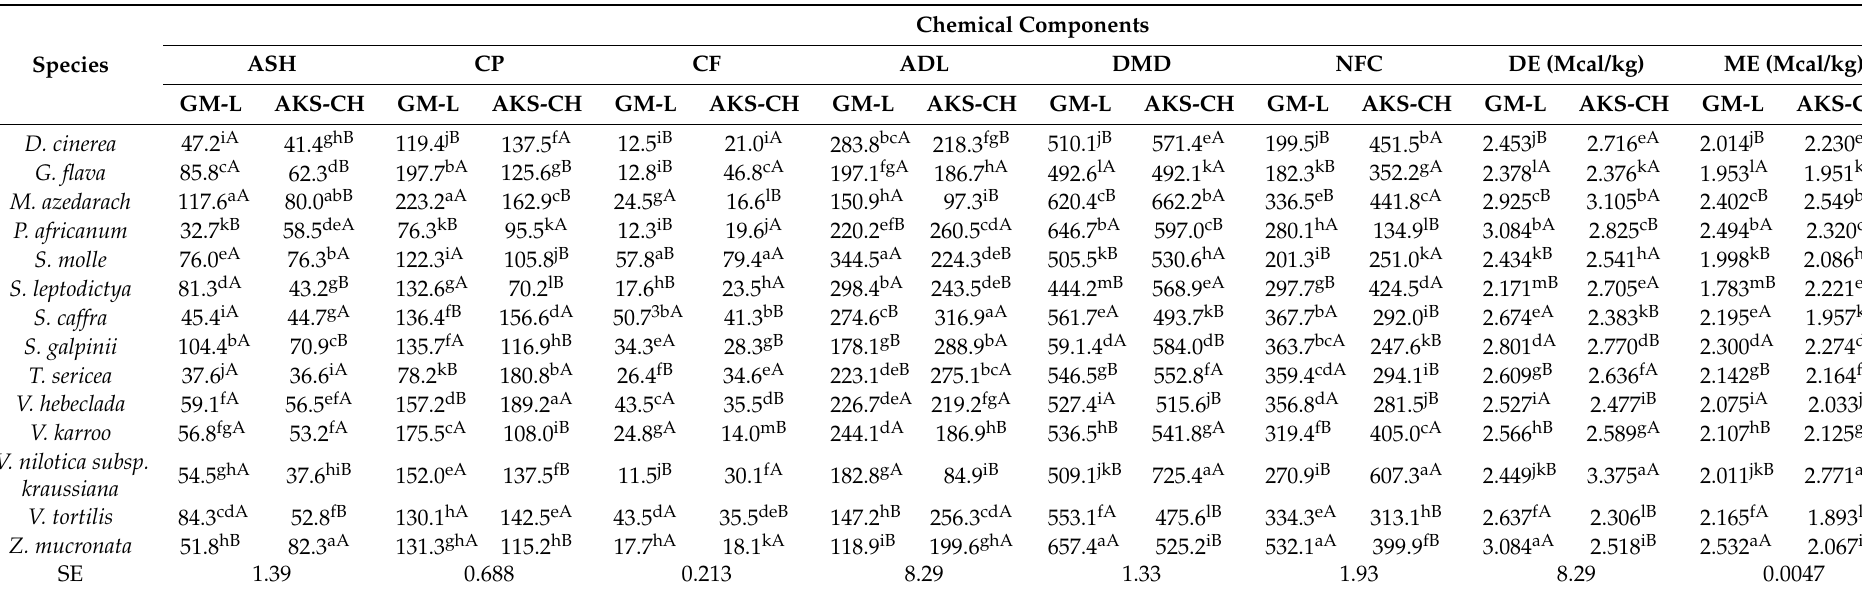
Table 3. Effect of species and soil type on chemical composition (g/kg DM, unless otherwise stated) of browse species found in GM-L and AKS-CH soil types.